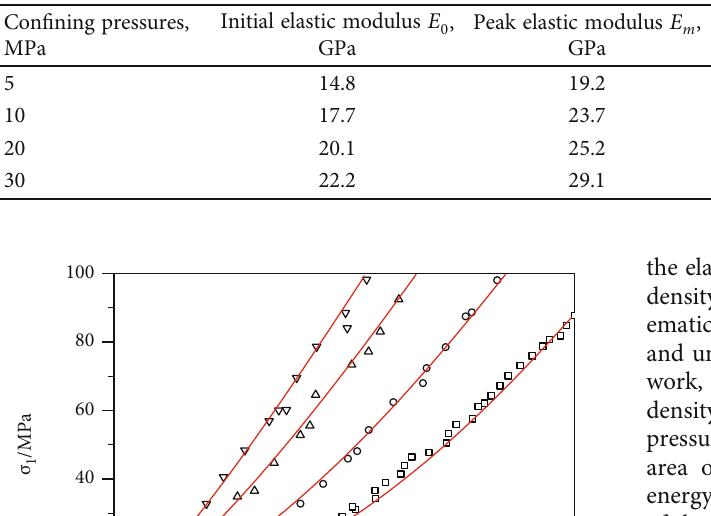
Figure 7: Unloading curves and evolution of elastic modulus under 30MPa con fi ning pressure. Table 2: Related parameters of elastic modulus.